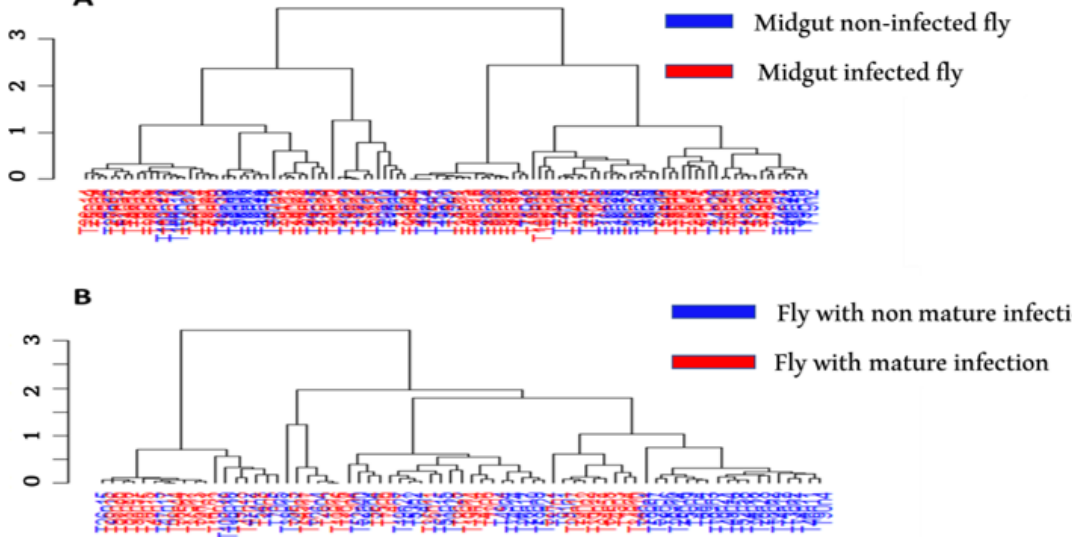
Figure 10. Hierarchical cluster dendrogram, based on Bray–Curtis Index values, showing the relationship between different tsetse microbiome communities and infection status. ( A ) midgut infection with trypanosomes, ( B ) mature infection with trypanosomes.